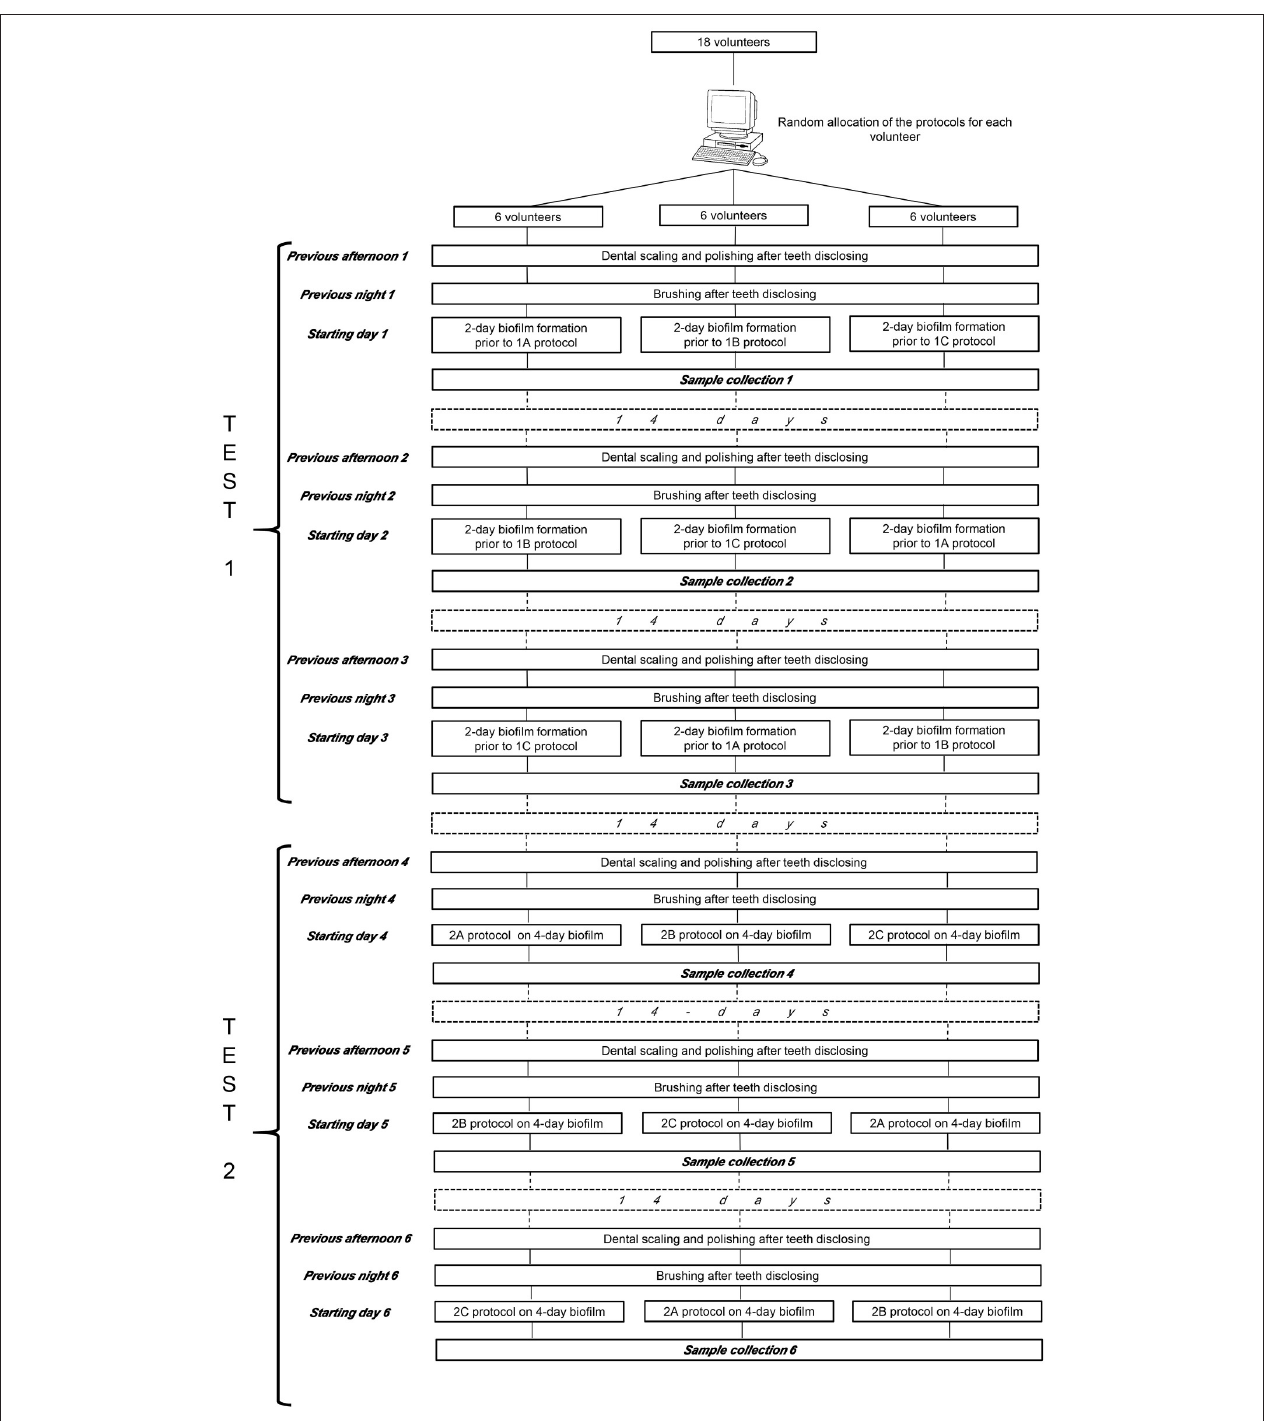
FIGURE 1 | Protocol of the study.